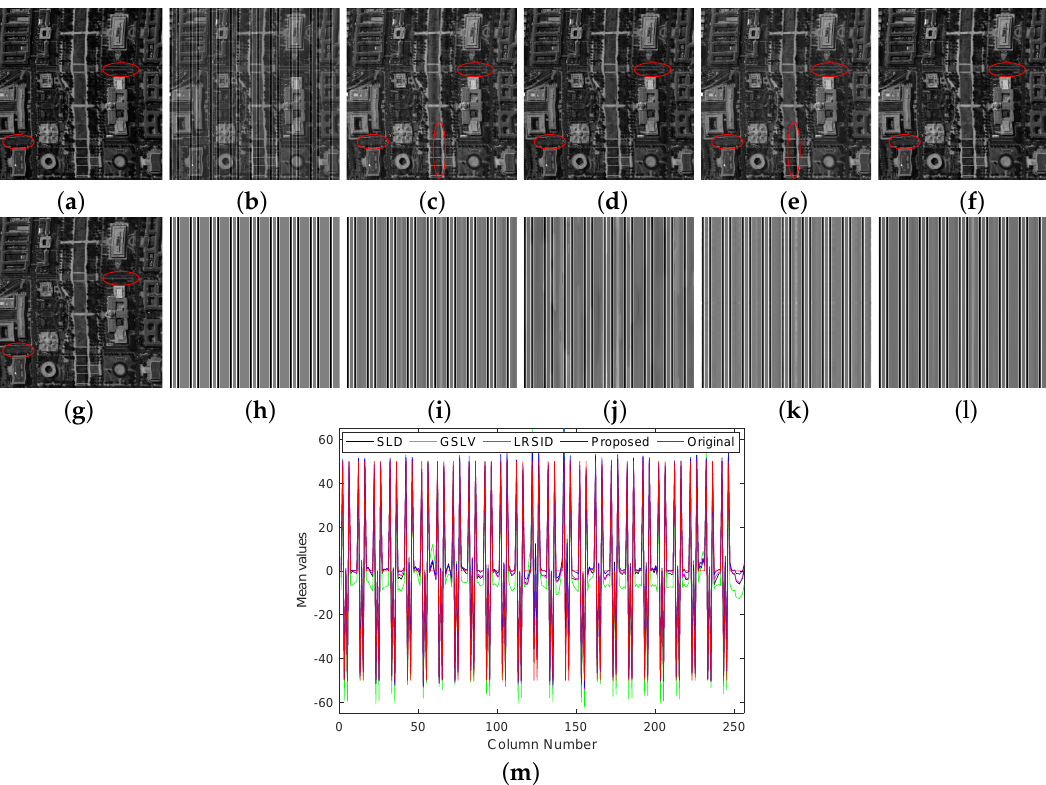
Figure 4. Destriping results with the simulated periodic stripes case. ( a ) Original hyperspectral image; ( b ) degraded image with periodic stripes. Image component: ( c ) WAFT; ( d ) SLD; ( e ) GSLV; ( f ) LRSID; ( g ) the proposed method. Stripe component: ( h ) original added stripes; ( i ) SLD; ( j ) GSLV; ( k ) LRSID; ( l ) the proposed method; ( m ) mean value comparison between the stripes estimated by SLD, GSLV, LRSID, the proposed method, and the original one ( h